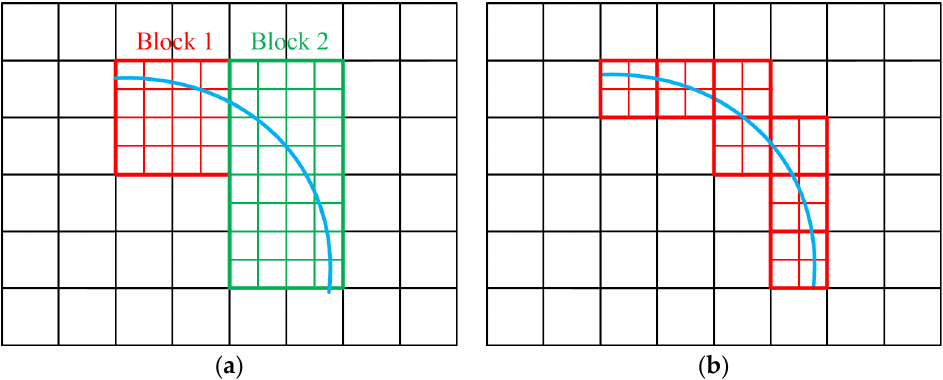
Figure 1. Different types of adaptive mesh refinement: ( a ) block-based AMR method; ( b ) cell-based AMR method.